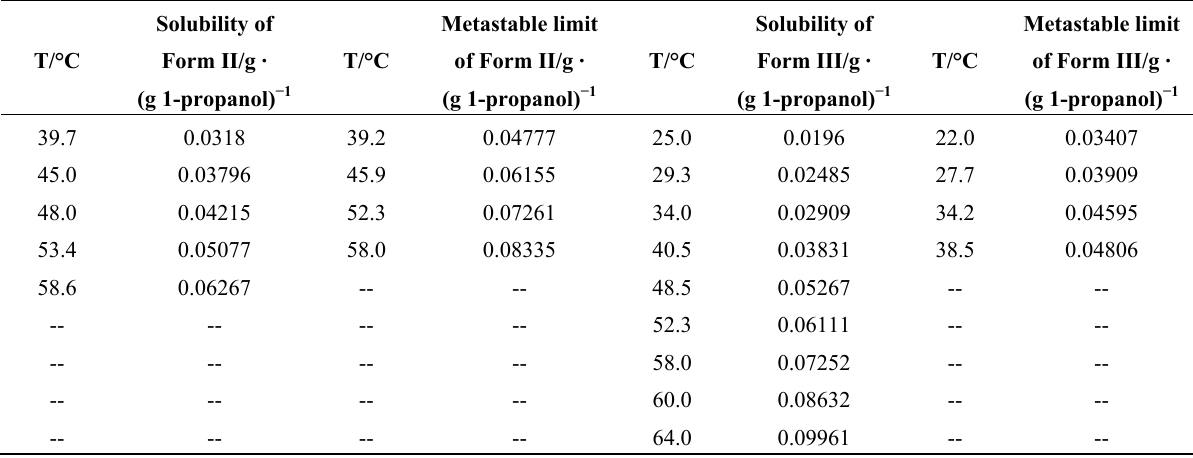
Table 2. The solubility and metastable limit data of carbamazepine Forms II and III in